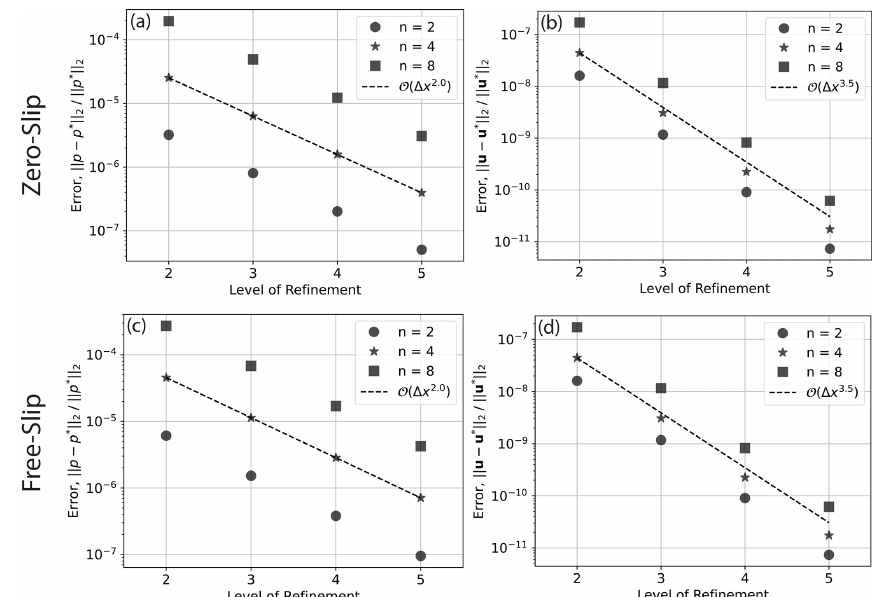
Figure A2. Convergence for 2-D cylindrical shell cases with zero-slip (a–b) and free-slip (c–d) boundary conditions using a Q2P 1DG finite- element pair for the Stokes system, driven by a delta-function forcing at different wave numbers, n , as indicated in the legend (see Kramer et al., 2021a, for further details). Convergence rate is indicated by dashed lines, with the order of convergence provided in the legend. For the cases plotted, the series of meshes start at refinement level 1, where the mesh consists of 1024 divisions in the tangential direction and 64 radial layers. At each subsequent level the mesh is refined by doubling resolution in both